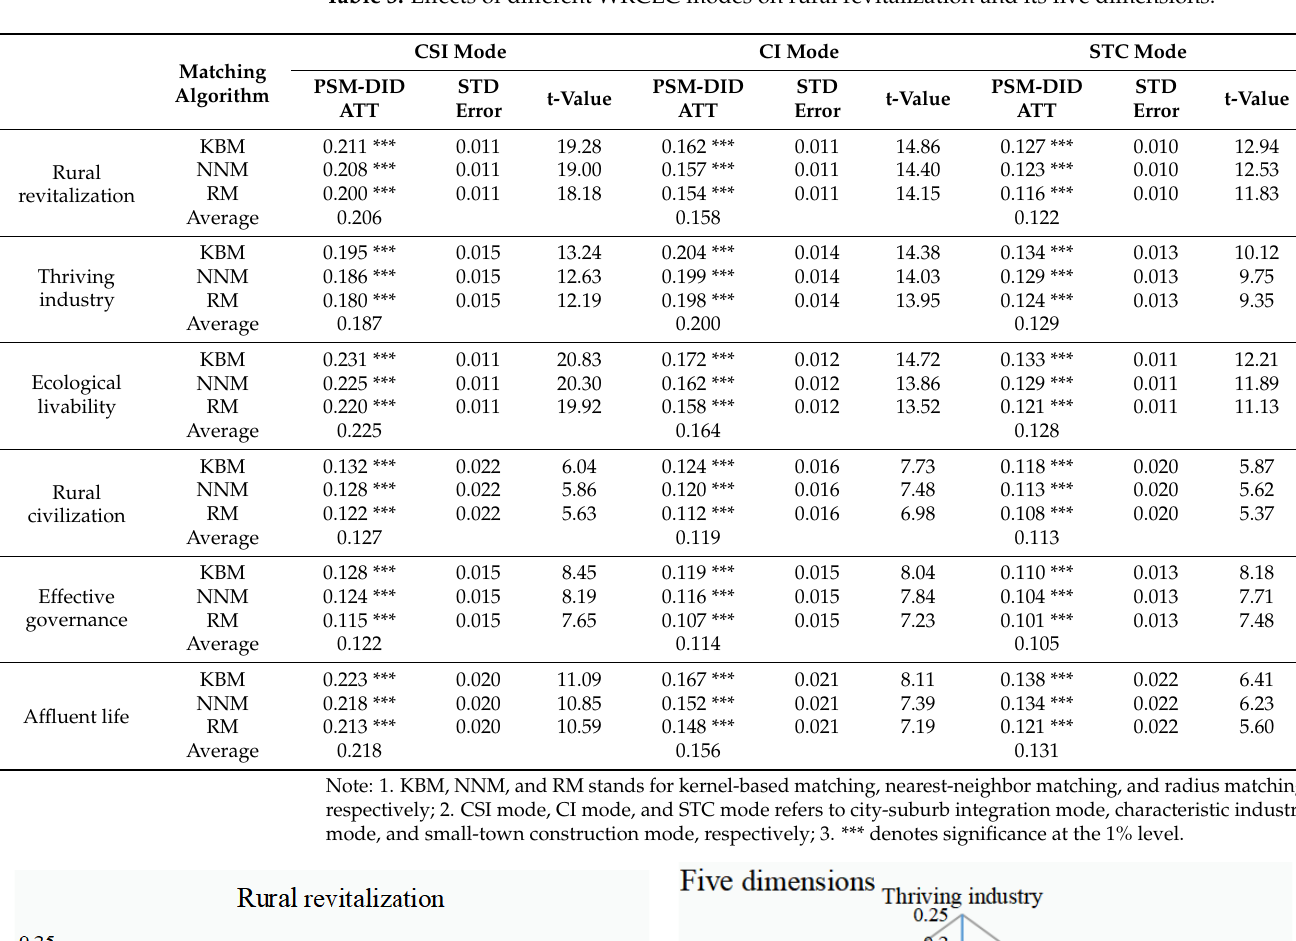
Table 3. Effects of different WRCLC modes on rural revitalization and its five dimensions.